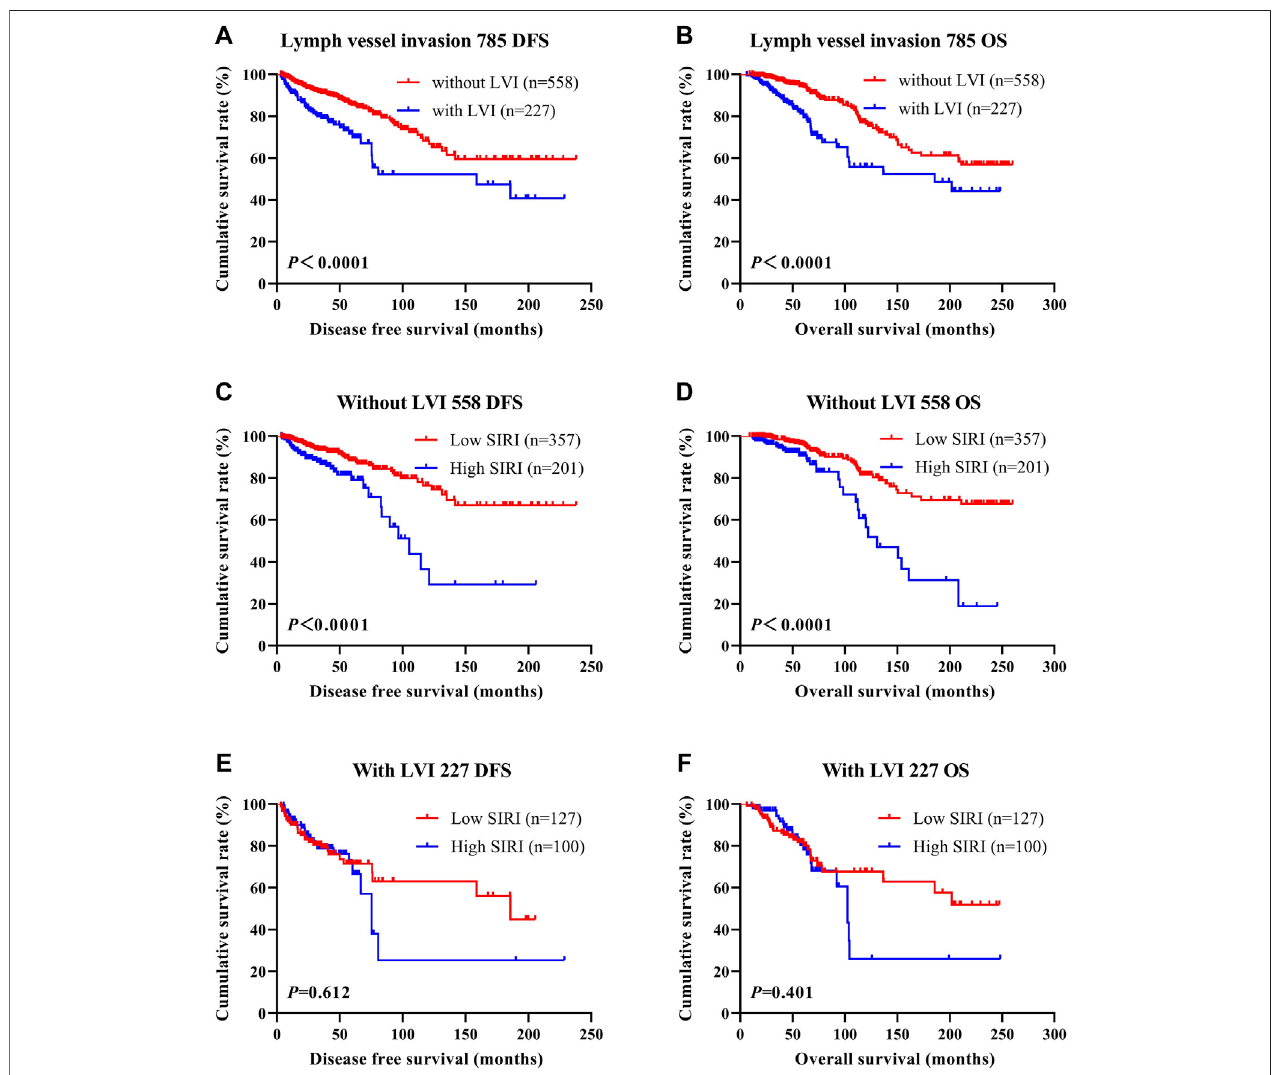
FIGURE6| DFSandOSbasedonthepresenceoflymphvesselinvasioninbreastcancerpatients.DFSandOSbasedonthepresenceoflymphvesselinvasionin breast cancer patients. (A) Kaplan-Meier analysis of DFS for the SIRI of all patients with breast cancer. (B) Kaplan-Meier analysis of OS for the SIRI of all patients with breast cancer. (C) Kaplan-Meier analysis of DFS for the SIRI of breast cancer patients without lymph vessel invasion. (D) Kaplan-Meier analysis of OS for the SIRI of breastcancerpatientswithoutlymphvesselinvasion. (E) Kaplan-MeieranalysisofDFSfortheSIRIofbreastcancerpatientswithlymphvesselinvasion. (F) Kaplan- Meier analysis of OS for the SIRI of breast cancer patients with lymph vessel